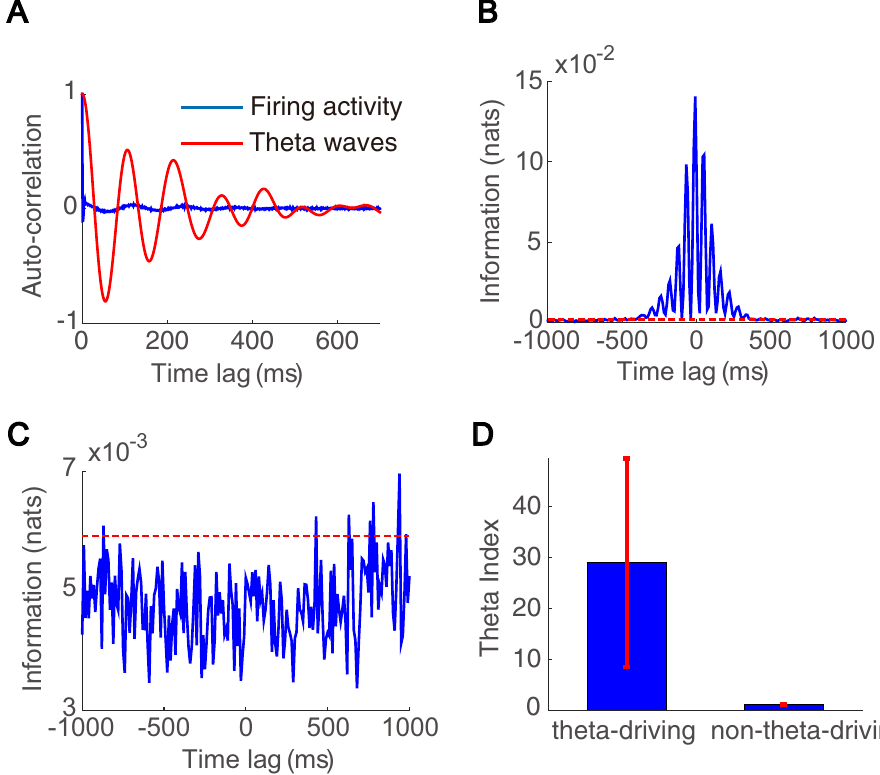
Figure 2. Interaction between theta-locked interneurons and theta waves in the AE state. ( A ) Auto-correlation of the theta-driving neuron’s firing activity (blue) and the corresponding theta wave (red). ( B ) Time-delayed mutual information between the firing activity of a theta-driving neuron and the corresponding theta wave. ( C ) Time-delayed mutual information between the firing activity of a theta-locked non-theta-driving neuron and the theta wave. In ( B , C ), we plot the mutual information as a function of time delay (blue) and its significance level (red). ( D ) Theta index for theta-driving neurons as well as non-theta-driving neurons. Blue bars and red bars indicate the mean and the range of theta index values for the six theta-driving neurons and four non-theta- driving neurons, respectively.